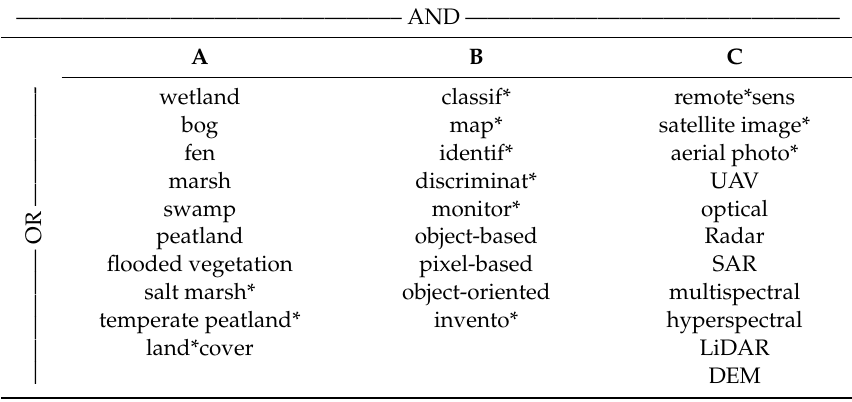
Figure 8. Flowchart demonstrating the selection of studies. 336 Table 1. Search query design (DEM: Digital Elevation Model, LiDAR: Light Detection And Ranging, 337 SAR: Synthetic Aperture Radar, UAV: Unmanned Aerial Vehicle). 338